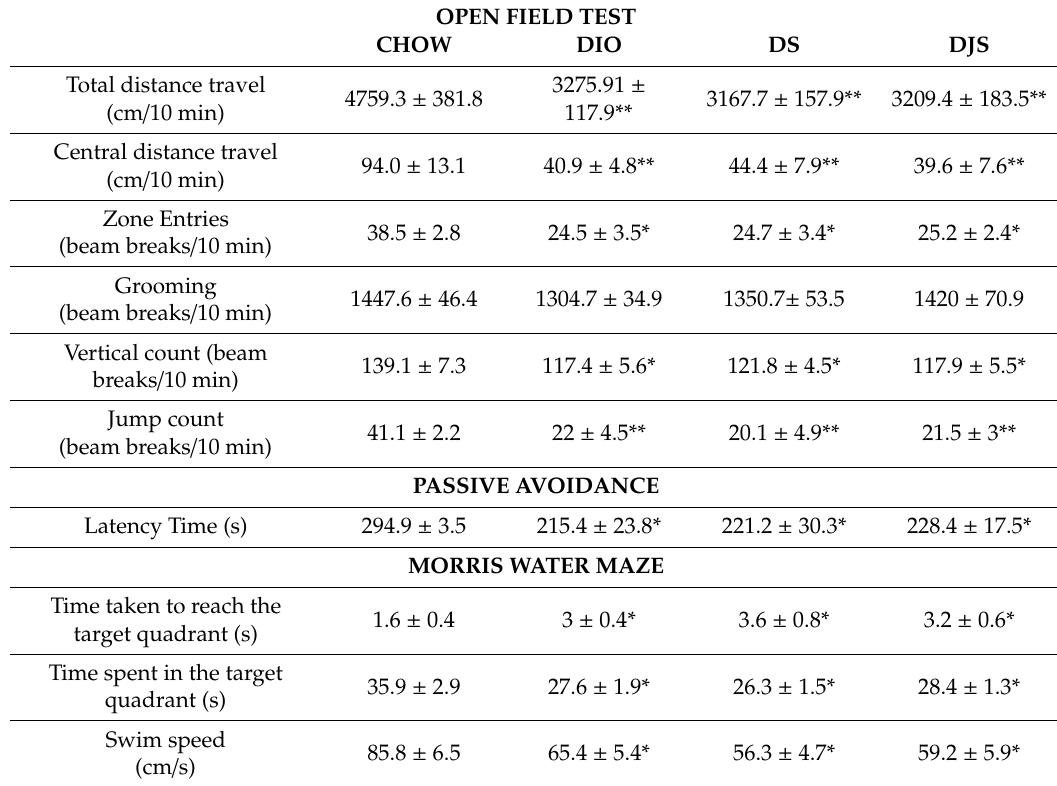
Table 3. Behavioral